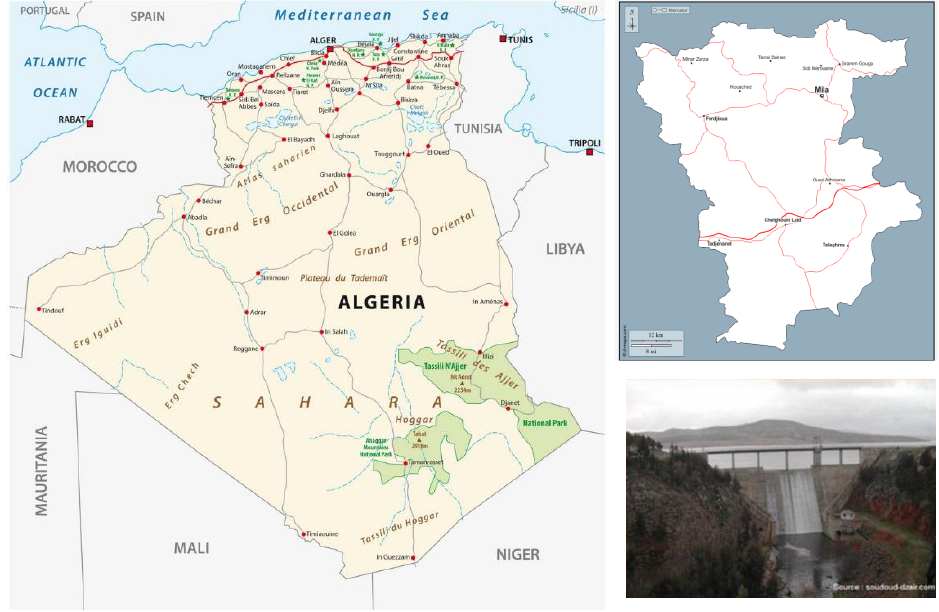
Figure 1. Geographic situation of Hammam Grouz dam, Algeria